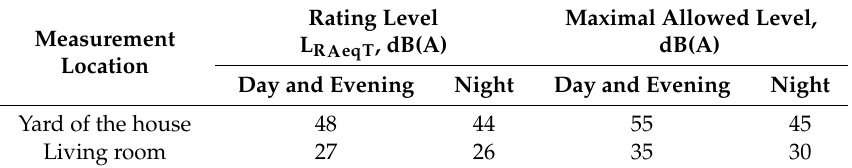
Table 1. Results of noise measurements in vicinity of the Veliki Krivelj open pit mine.